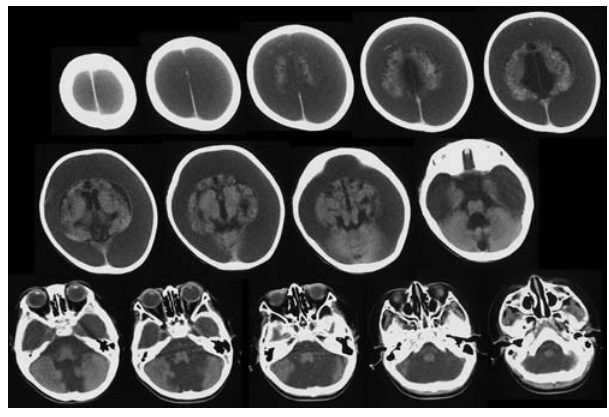
Figure 1. Brain computed tomography of a 6-year-old boy (indicated with * in Table 1). He suffered from severe cortical atrophy and massive subdural fluid collection.